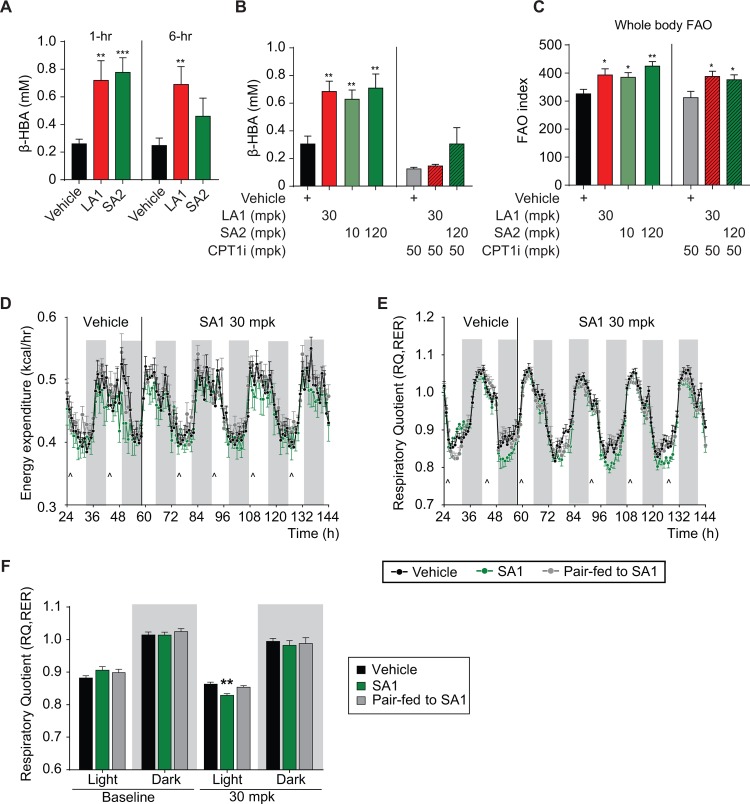
Effect of AMPK activators on FAO in db/db mice (A-C) and energy expenditure, respiratory exchange ratio and FAO in lean C57BL/6 mice (D-F, n = 8). (A–C) Plasma level of β-hydroxybutyrate and FAO index determined by D2O-labeled oleate oxidation in 8 week old db/db mice treated with vehicle, LA1 (30 mg/kg), SA2 (30 mg/kg (A), 10–120 mg/kg (B-C)), CPT-1 inhibitor (CPT-1i) (50 mg/kg), and SA2 (120 mg/kg) + CPT-1i (50 mg/kg), all QD, PO. (D) Time curve of whole body energy expenditure in 12 week old lean C57BL/6 mice (average body weight of 25 grams) housed in metabolic cages at baseline and after treatment with vehicle (0.25% MC, 5% Tween-80, 0.02% SDS, 5mM HCl, and 60mg/kg HPMCP polymer) or SA1 at 30 mg/kg (QD, PO indicated by arrows) or mice pair-fed to the SA1 group. (E—F) Respiratory quotient (RQ, or respiratory exchange ratio, RER) in mice after treatment with vehicle or SA1 at 30 mg/kg (QD, PO indicated by arrows) or mice pair-fed to the SA1 group. Data are represented as mean ± SEM. *p < 0.05, **p < 0. 01, *** p < 0.001 relative to vehicle.